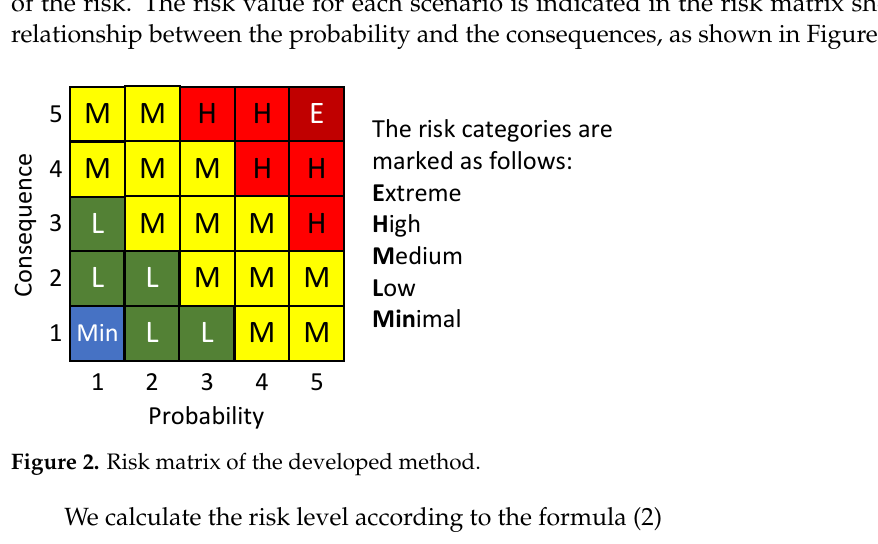
Table 3. Scale of the hierarchy of risk control measures.